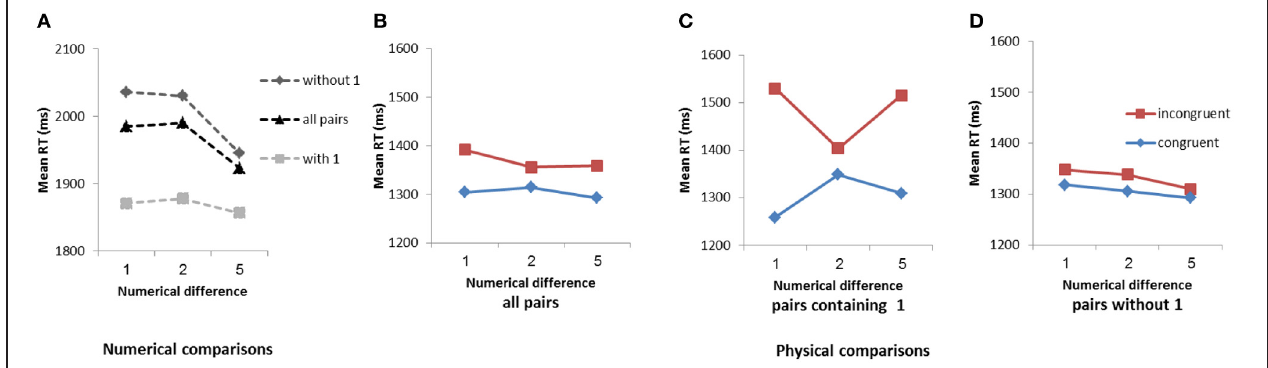
FIGURE 1 | Mean RTs in the numerical comparison task as a function of pair type and numerical difference (A). Mean RTs in the physical comparison task as a function of congruency and numerical difference for all pair types (B) , for pairs that contain 1 (C) , and for pairs without 1 (D)